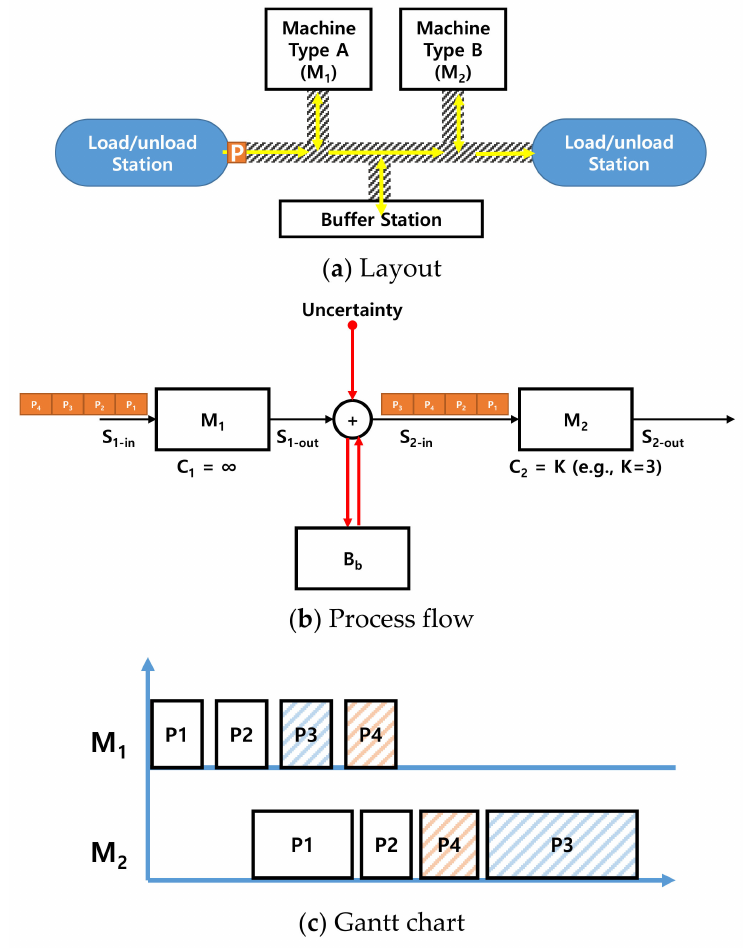
Figure 7. Example of a JS-FMS with